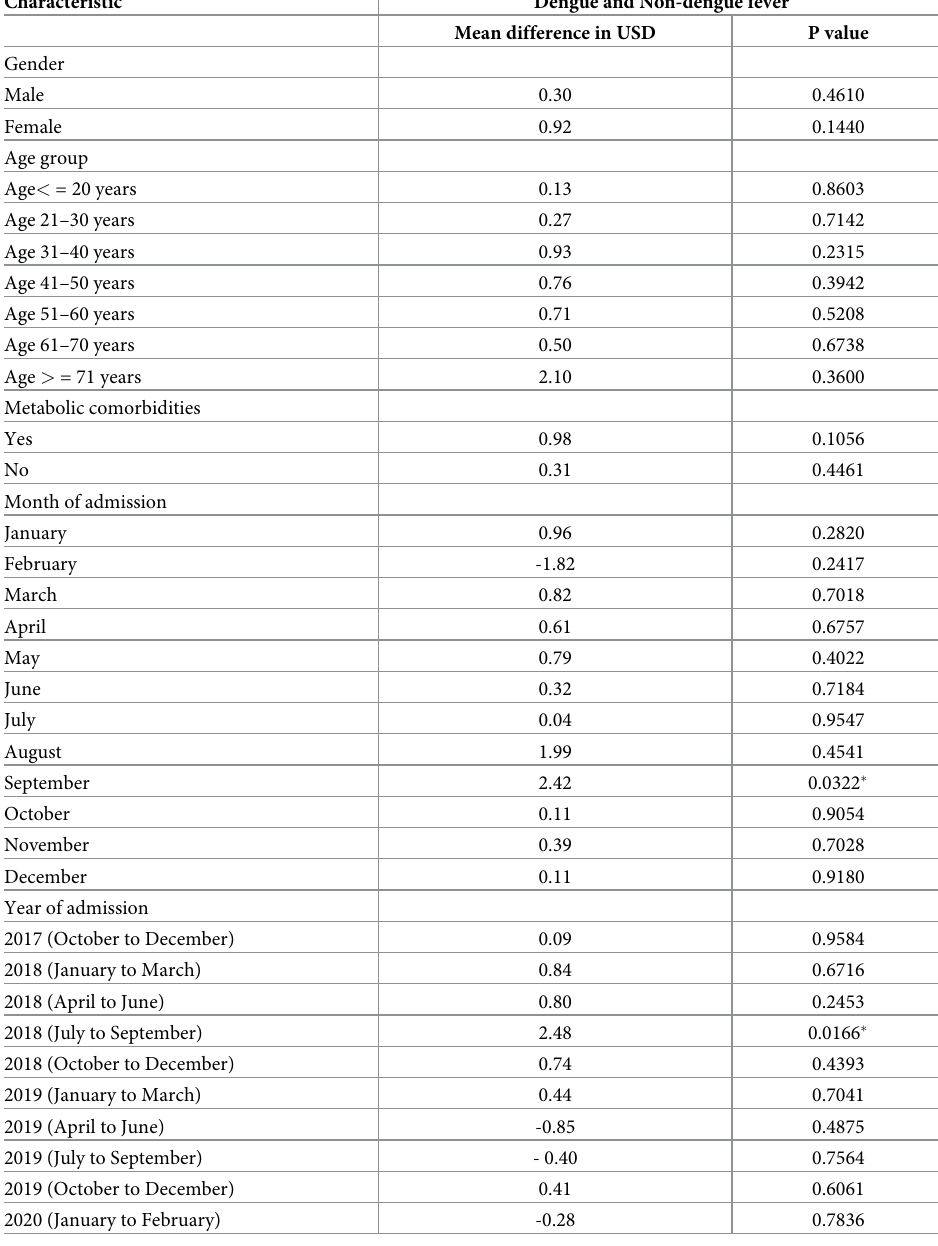
Table 3. Mean differences of costs across DF and NDF patient groups (a positive mean difference indicates a higher cost in DF group, unit–cost per patient per day in USD).